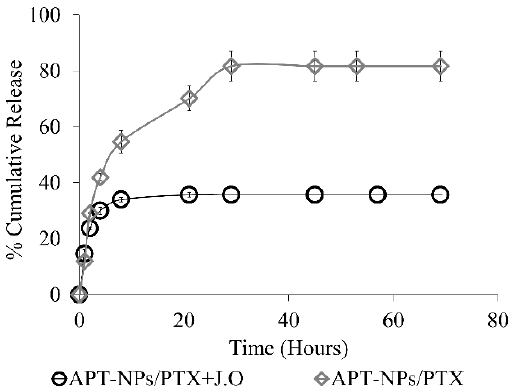
Figure 5. Drug release kinetics of 14 µM PTX from APT-NPs with and without 88 µM